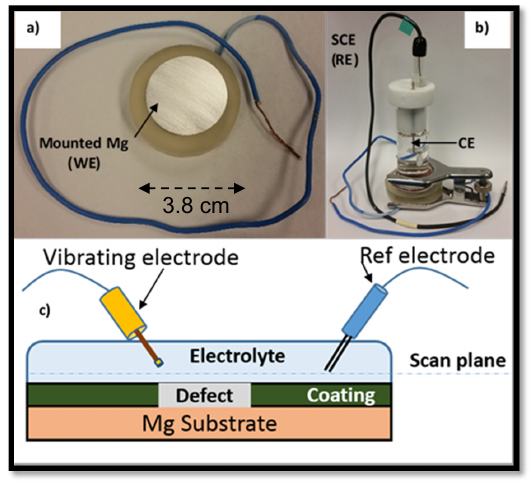
Figure 3. ( a ) Mounted magnesium AZ31 sample; ( b ) three electrode electrochemical configurations for EIS and PDS measurements; and, ( c ) schematic of SVET measurement.